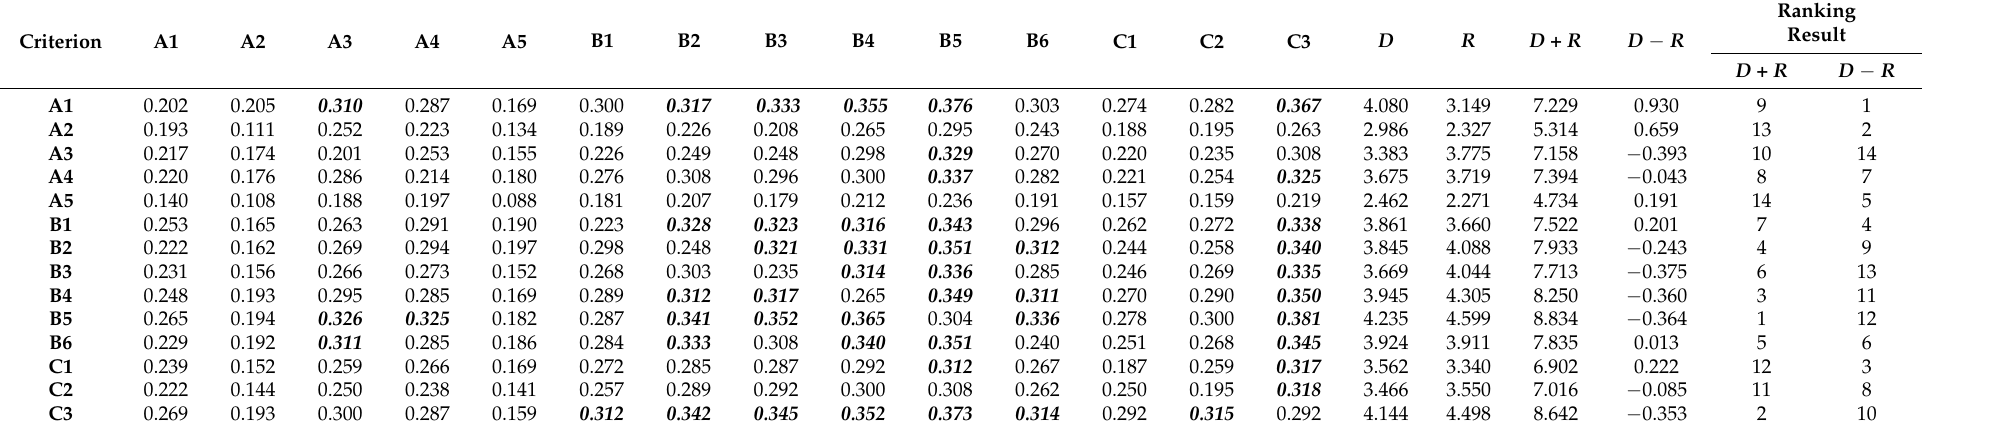
Table 2. The total-related matrix T of the criteria (threshold value ≥